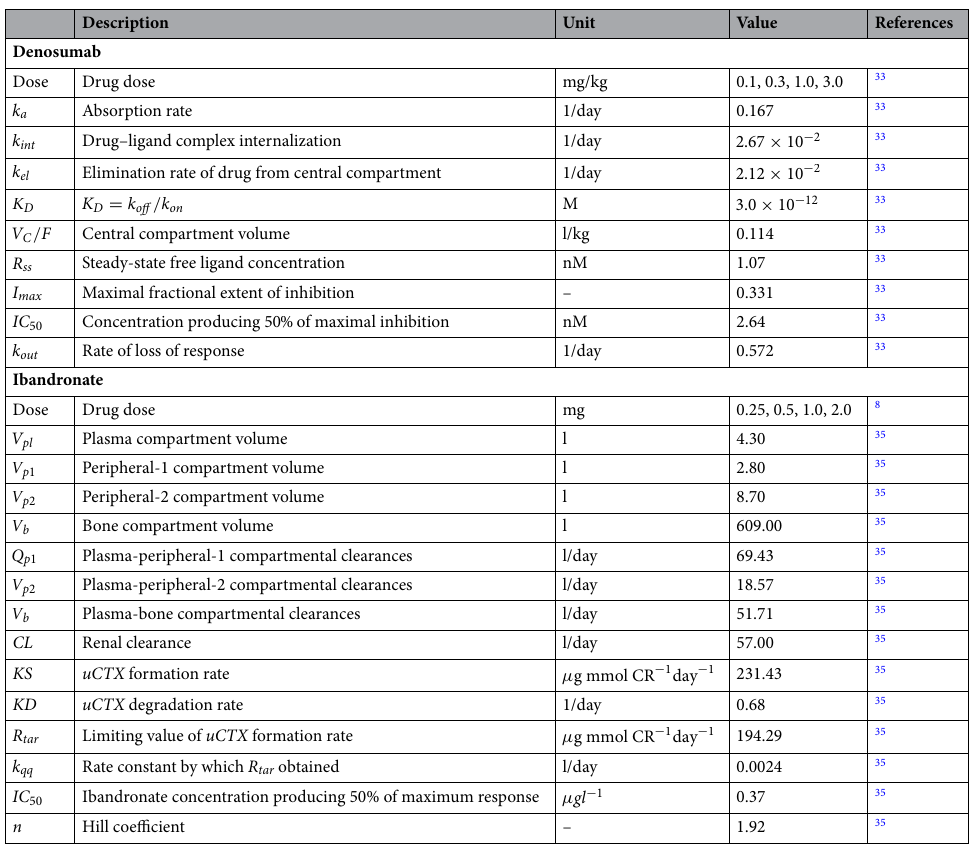
Table 2. Values and description of the mechanical